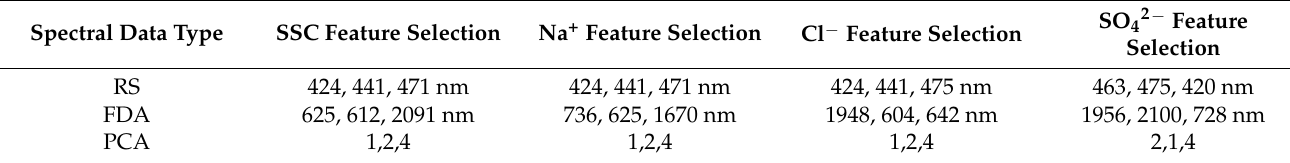
Figure 6. Correlation graph between the SSC, Na + , Cl − , and SO 42 − contents and each band of RS data ( a ), graph of the correlation with each band of FDA data ( b ), graph of the correlation with each component of PCA ( c ). Table 3. Based on the RS, FDA, and PCA data, the bands with the highest correlation with the SSC, Na + , Cl − , and SO 42 − contents were extracted as the characteristic bands sensitive to soil